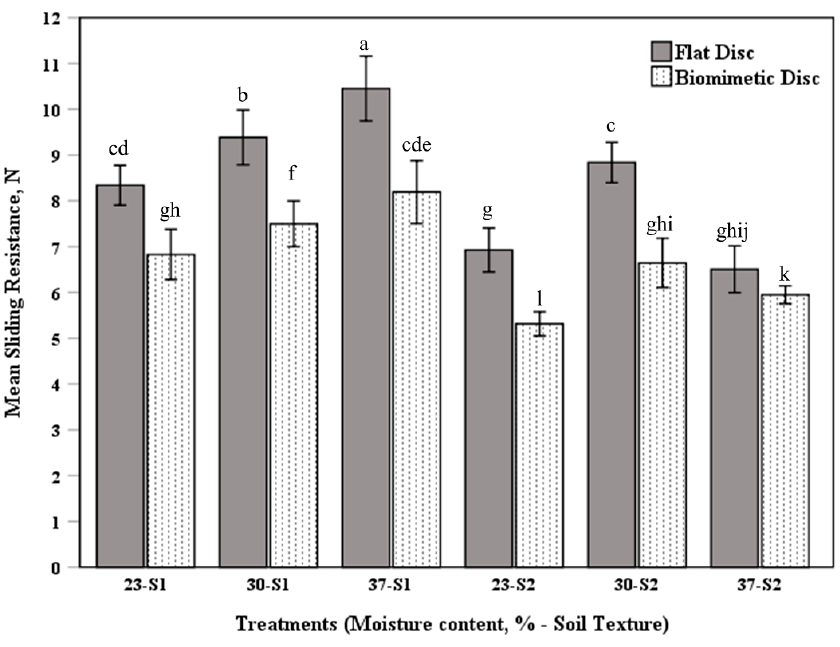
Figure 7. Comparing the mean drag force of the flat surface with that of the optimized biomimetic surface in all treatments. Means with different letters are significantly different.